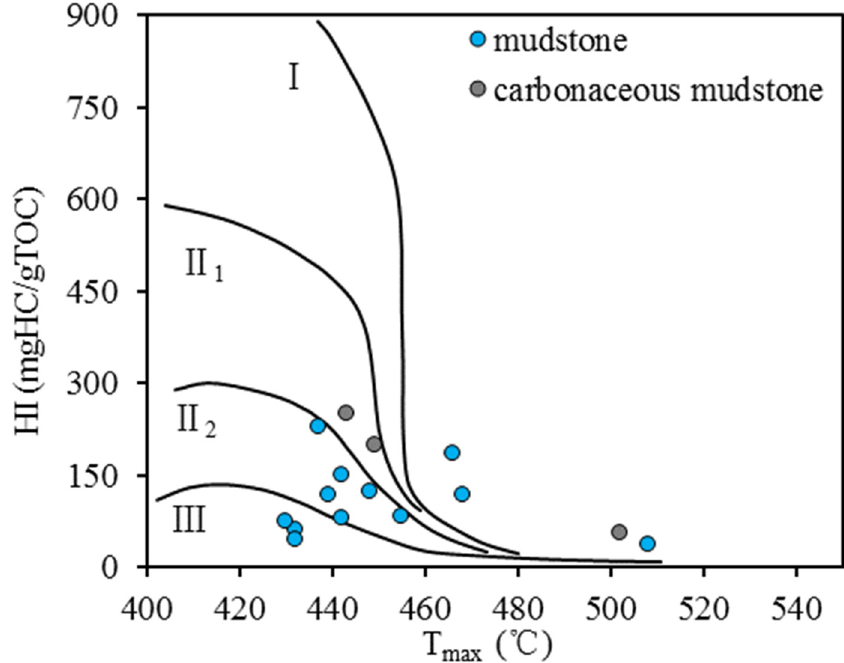
Figure 4. Organic matter types of coal ‐ measure source rocks.